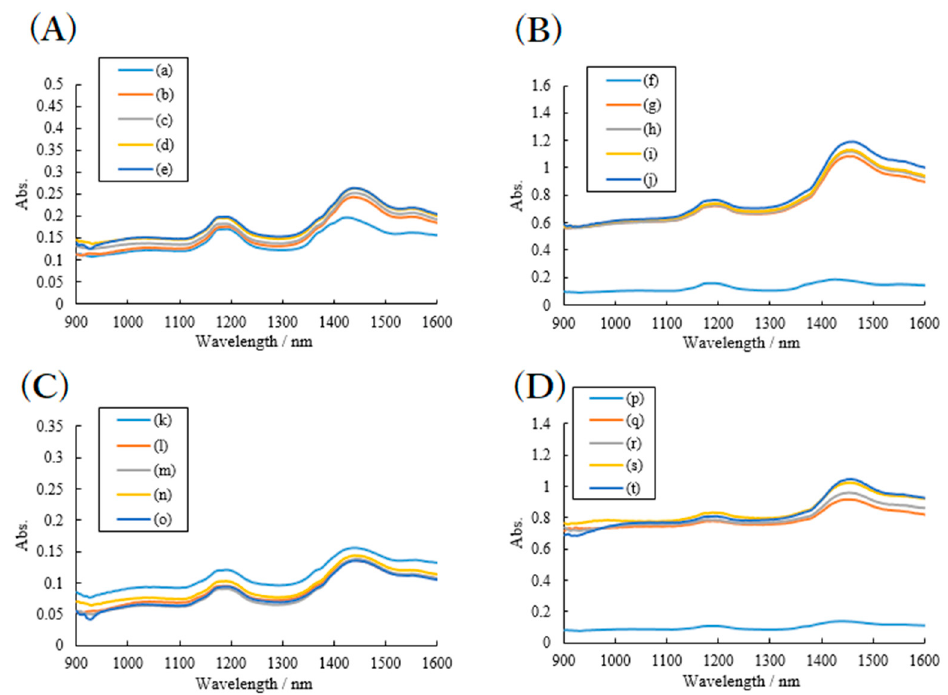
Figure 7. SNV normalized near-infrared spectra of stored RB, SDS, and PVP samples. Physical mixture samples in RH 30% ( A ) and RH 75% ( B ). Ground mixture samples in RH 30% ( C ) and RH 75% ( D ) ranging from 900 to 1600 nm. Storage time: 0 weeks (a, f, k, and p); 1 week (b, g, l, and q); 2 weeks (c, h, m, and r); 3 weeks (d, i, n, and s); 4 weeks (e, j, o, and t). RH; relative humidity. RB; rebamipide. SDS; sodium dodecyl sulfate. PVP; polyvinylpyrrolidone.